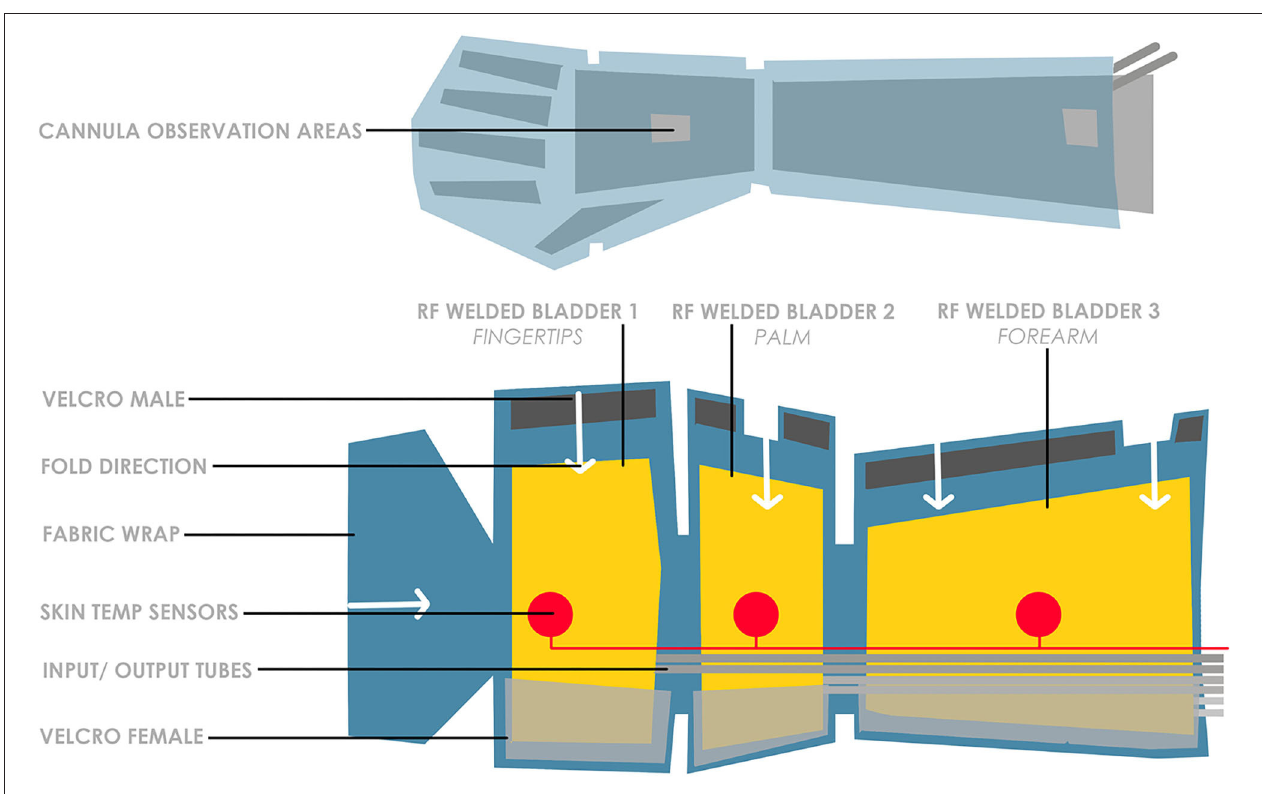
FIGURE 4 | Three-bladder cooling zones arm wrap concept.